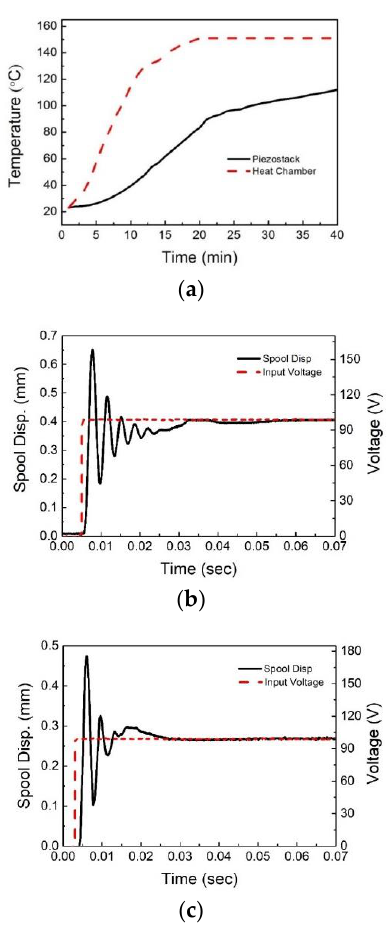
Figure 7. Temperature variation and step responses of the valve system, (a) Temperature variation, (b) Step response at 30 °C, (c) Step response at 150 °C .